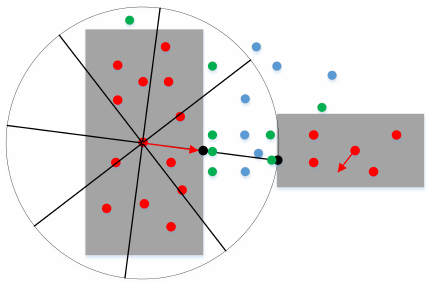
Figure 13. Optimizing obstacle points as the free points in narrow